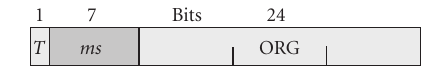
Figure 7: The layout of an element header.